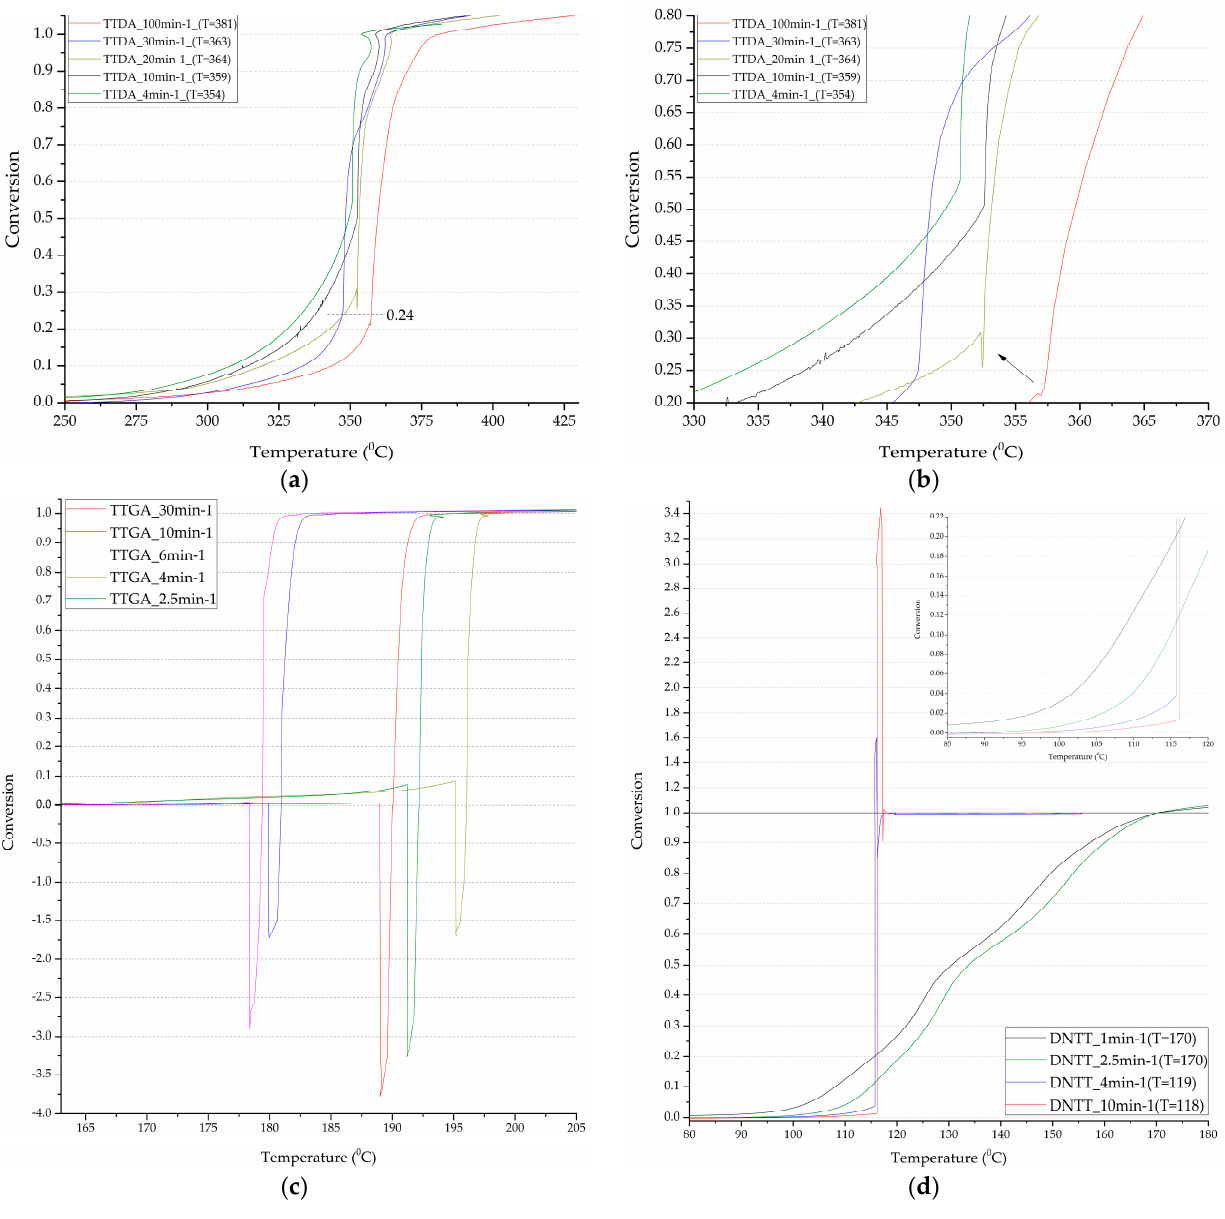
Figure 7. Integral decomposition curves of samples TTDA ( a , b ); TTGA ( c ); DNTT ( d ).